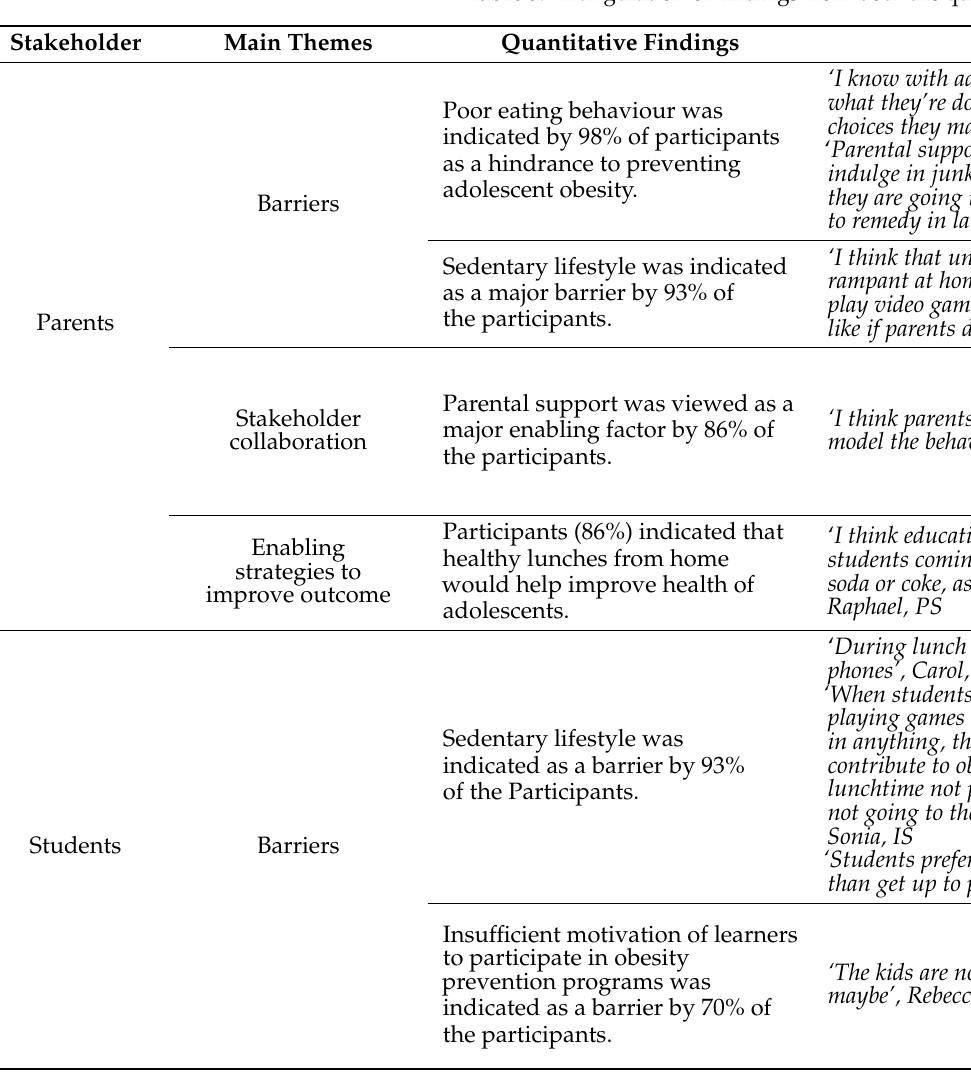
Table 5. Triangulation of findings from both the quantitative and qualitative phases of the